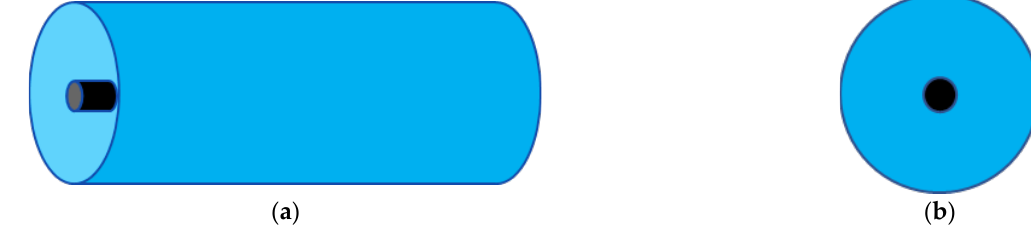
Figure 1. The schematic view of a dielectric fiber with a metal wire core ( a ) and its cross section ( b